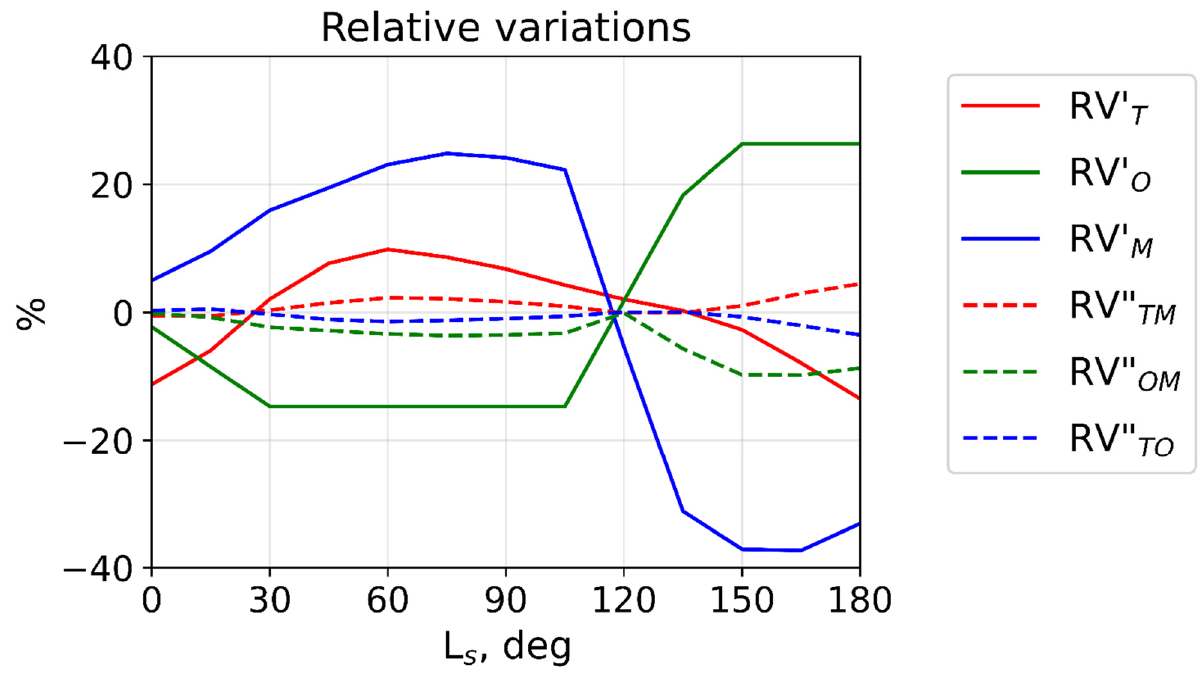
Figure 3. Relative variations calculated over the first half of the Martian year with (14) (solid lines) and (15) (dashed lines) at 40°N.